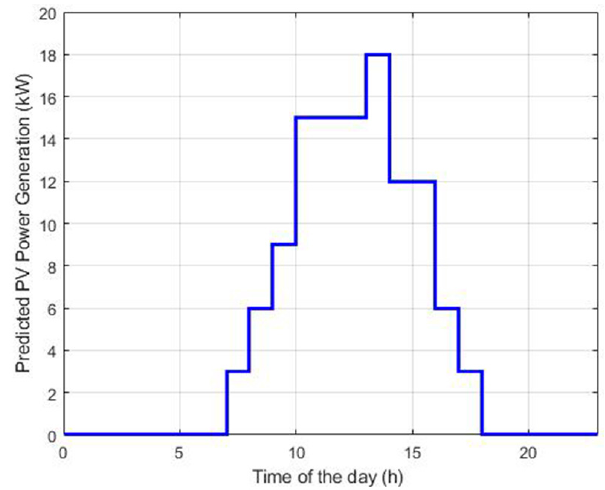
Figure 6. Predicted PV power generation in the microgrid.